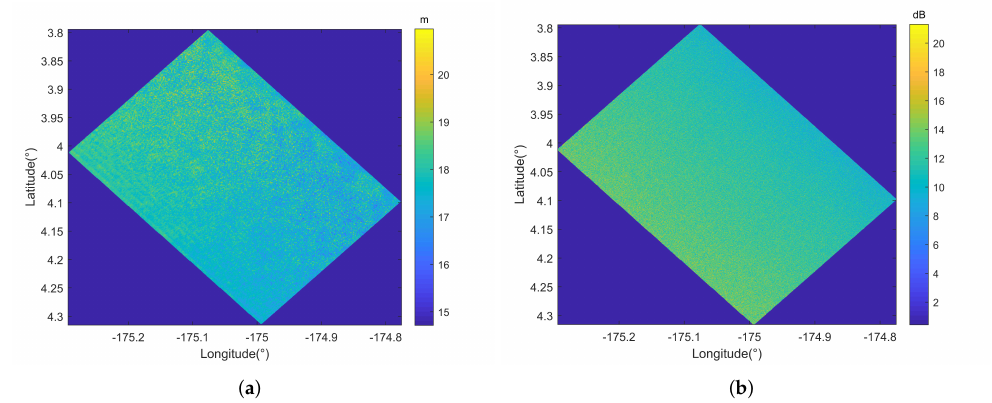
Figure 2. Ocean observation images of TG2-InIRA. ( a ) SSH; ( b ) σ 0